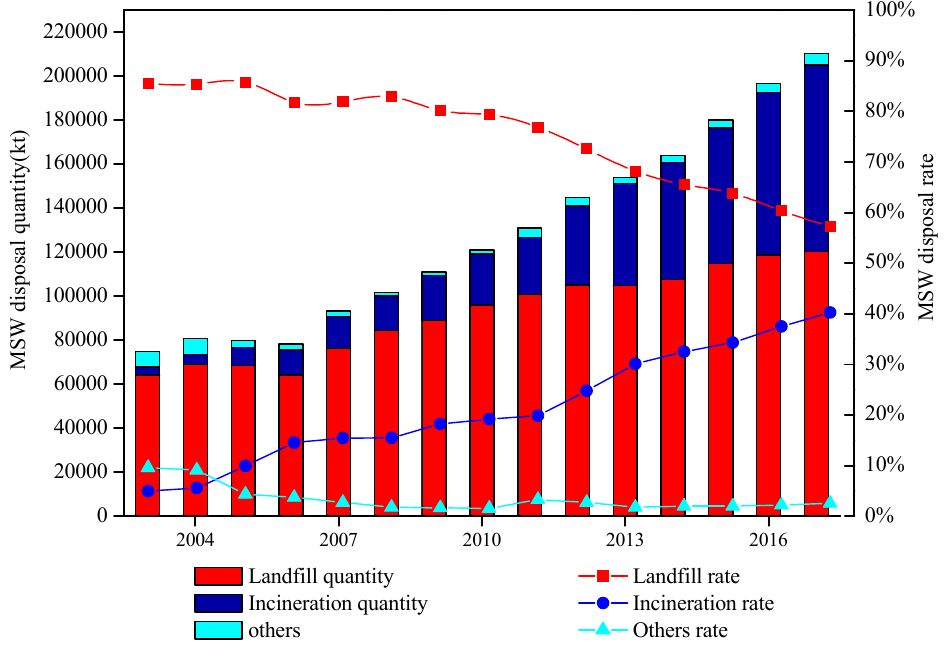
Figure 1. MSW quantity from 2004 to 2017 in China.